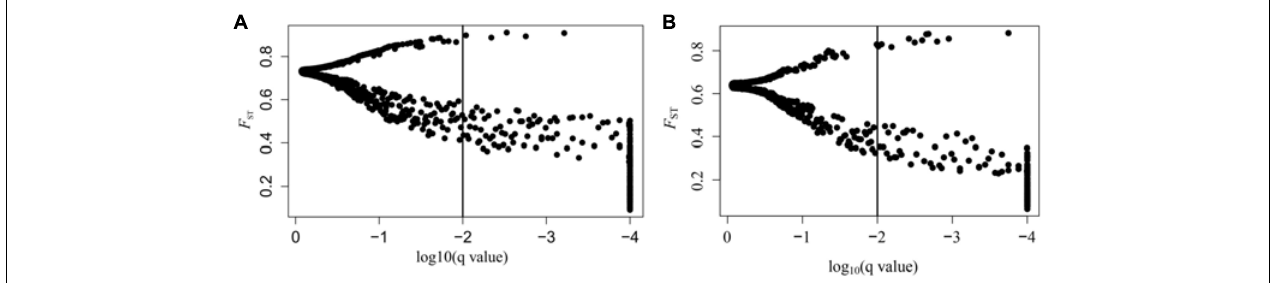
FIGURE 2 | Results of BayeScan. (A) F ST outliers of all A. squarrosum populations sampled in this study. The x -axis represents the q -value, which is standardized to log10, and the y -axis represents F ST values. (B) F ST outliers of sand rice populations of the Central lineage. The x -axis represents the q -value, which is standardized to log10, and the y -axis represents F ST values.